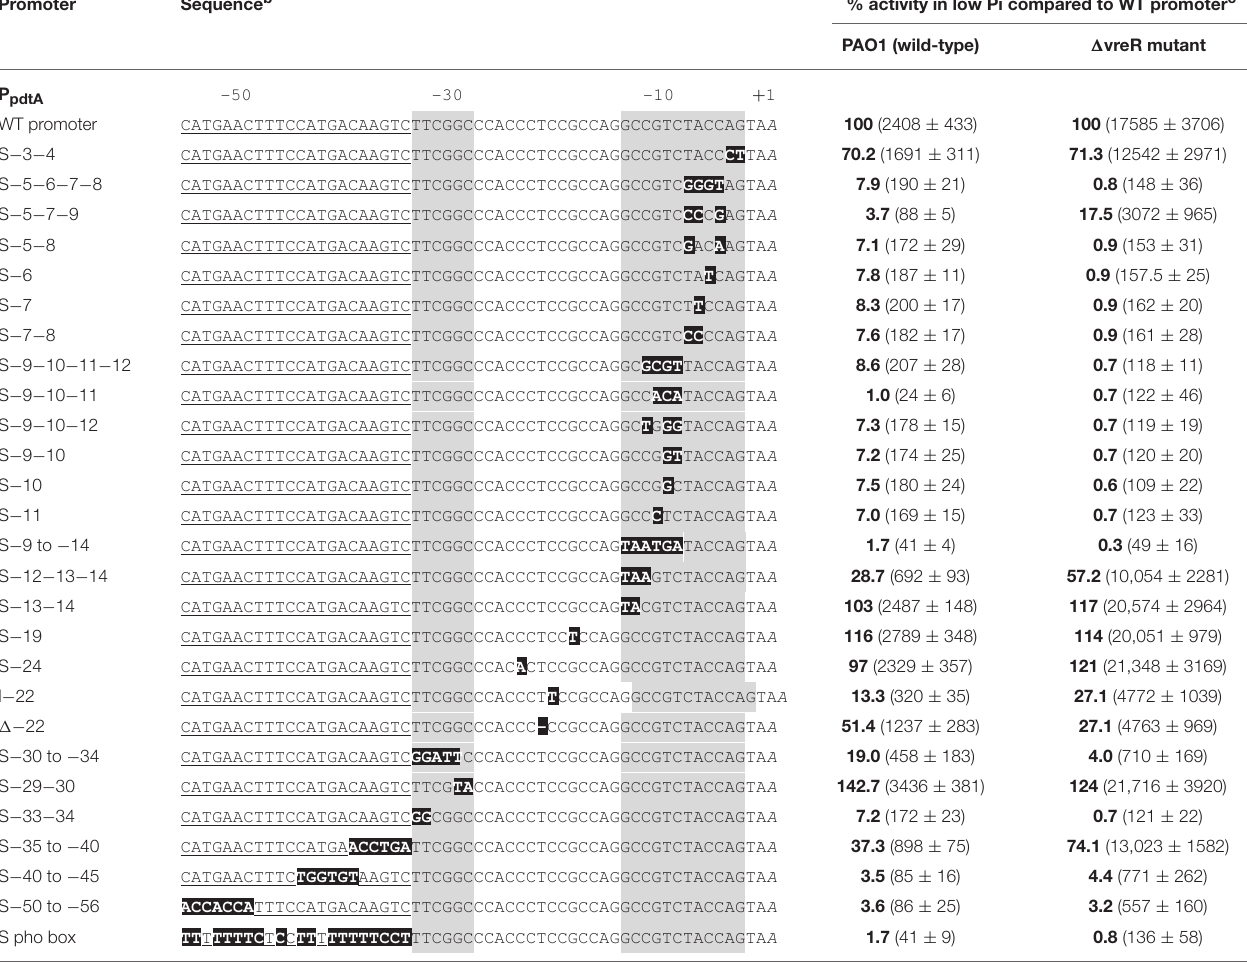
TABLE 2 | Mutagenesis of the pdtA promoter and activity a .